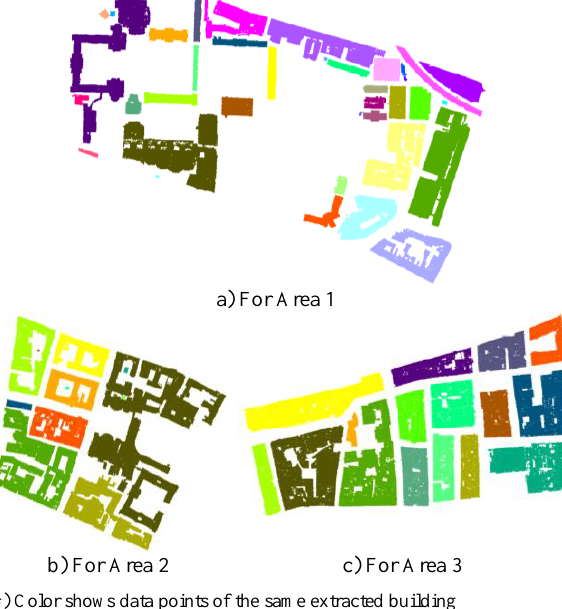
Figure 9. Point clouds of building/blocks extracted from the 3 designated study areas (*)